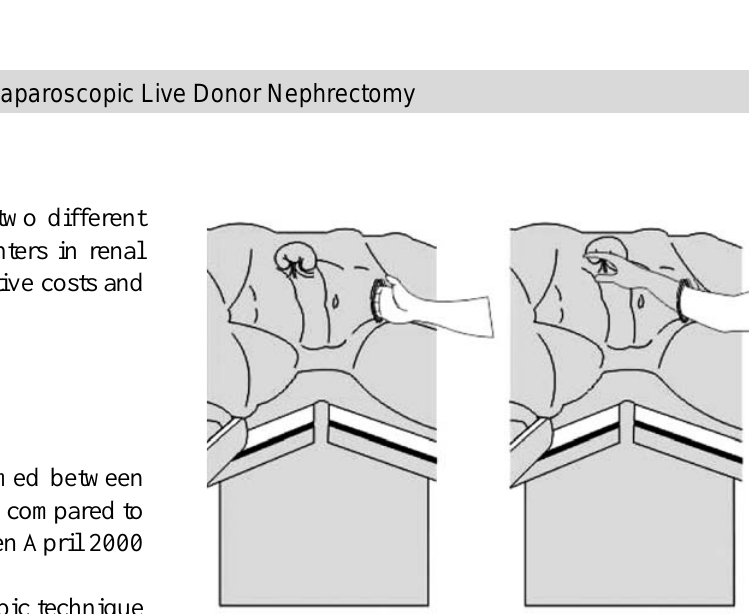
Figure 2 – Introduction of assistant’s arm in the peritoneal cavity without using any hand-assist device.